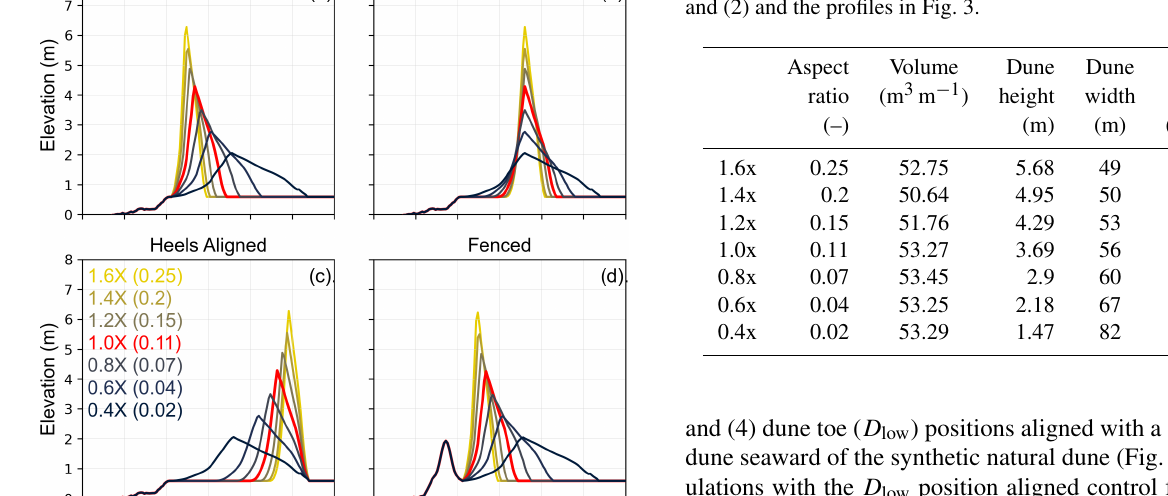
Table 1. Initial dune shape parameters for synthetic dune profiles used in this study. Note that dune height is measured from the dune crest to the dune toe, the initial dune toe elevation is constant at 0.59m for all profiles. The values in the left column refer to the modification to the reference dune profile as described in Eqs. (1) and (2) and the profiles in Fig.